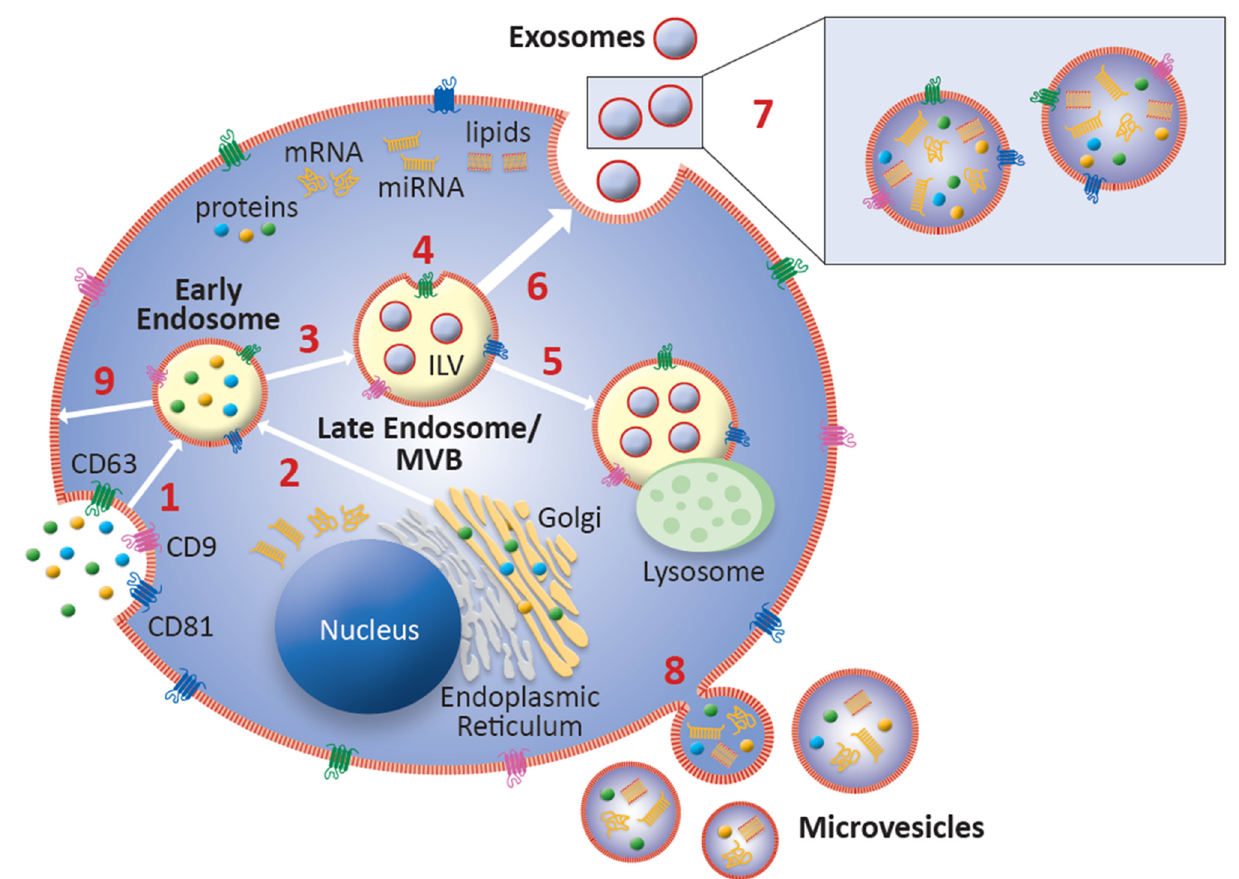
Figure 1. Exosome biogenesis. (1) Invagination of the plasma membrane of the cell collects extracellular material and generates a membrane bound endosome within the cell which retains plasma membrane proteins such as tetraspanins. (2) Golgi network packaging and transport of cellular material to the endosome. (3) Endosomal sorting complex required for transport (ESCRT) machinery packaging of biomaterial. (4) Invagination of the endosome forms intraluminal vesicles (ILVs). The collection of ILVs within an endosome forms a multivesicular body (MVB). There is cellular content from the cytosol contained within the ILVs as a result of microautophagy. (5) Trafficking of the MVB to the lysosome. MVB fusion with the lysosome results in ILV degradation. (6) Exosomes are released when the ILVs are released following MVB fusion with the plasma membrane. (7) Close-up of exosomes at release, with tetraspanins and bioactive cargo. (8) Budding of the plasma membrane forming microvesicles. These extracellular vesicles (EVs) are distinguishable from exosomes by nature of their biogenesis, and size. (9) Recycling of early endosome content to the plasma membrane.